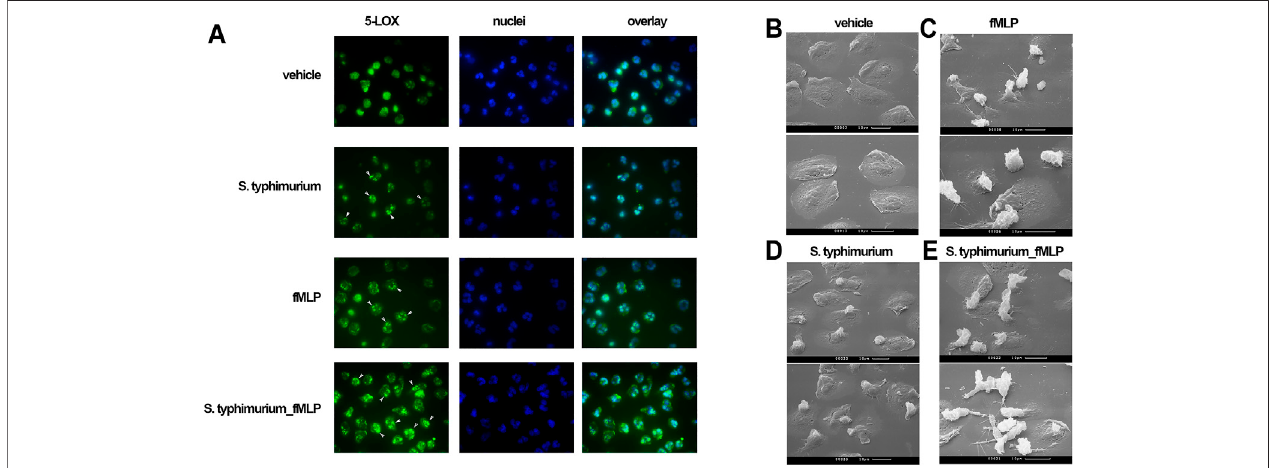
FIGURE 3 | (A) Subcellular localization of 5-LOX by immunostaining. PMNLs (2 × 10 6 /mL HBSS/HEPES) were incubated without additived (vehicle), with nonopsonized S.typhimurium (25:1bacteriapercellratio),with0.1 µMfMLPorundersequential stimulation withtheseagentsatintervalsof20 min.The fi nalincubation with fMLP in this case lasted 5 min. At the end of the incubation, the cells were fi xed and stained for 5-LOX (green). Samples were also stained for DNA with Hoechst (blue). (B – E) . Scanning electron microscopy appearance of neutrophils in co-incubation with bacteria and fMLP. PMNLs (10 6 /ml) in HBSS/HEPES medium were platedoncoverslipsandincubated for20 minat37 ° Cinthemedium (B,C) ,orwithnonopsonized S.typhimurium (25:1 bacteria percellratio) (D,E) ,followedbyadding fMLP (0.1 µM) for 5 min (C, E)